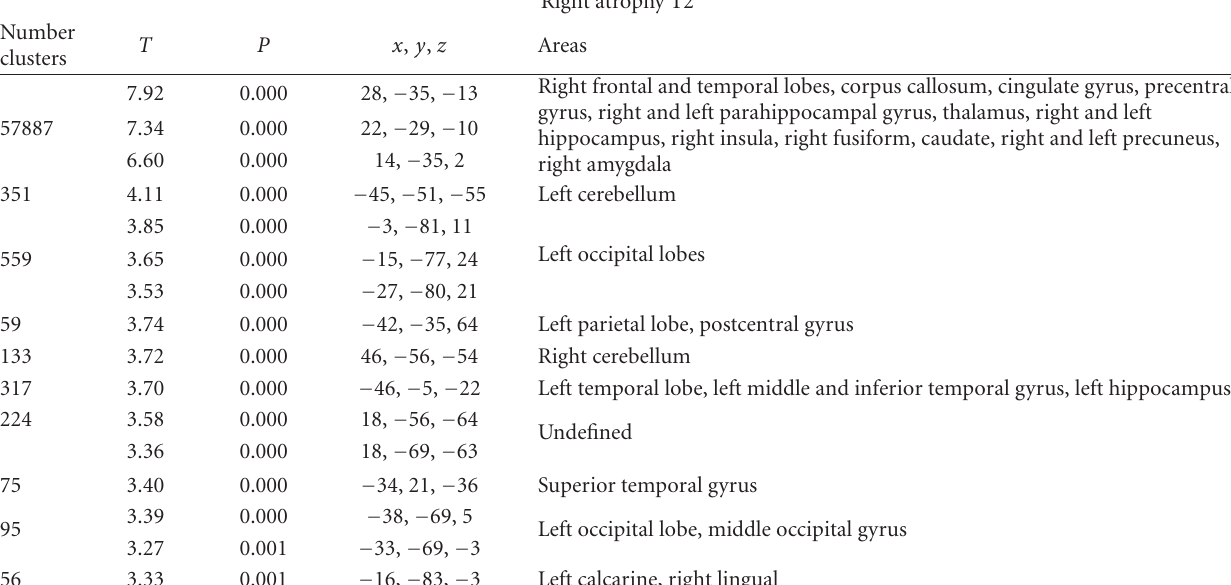
Table 5: Areas with WM atrophy in patients with right HA, from T2-weighted analysis. Right atrophy